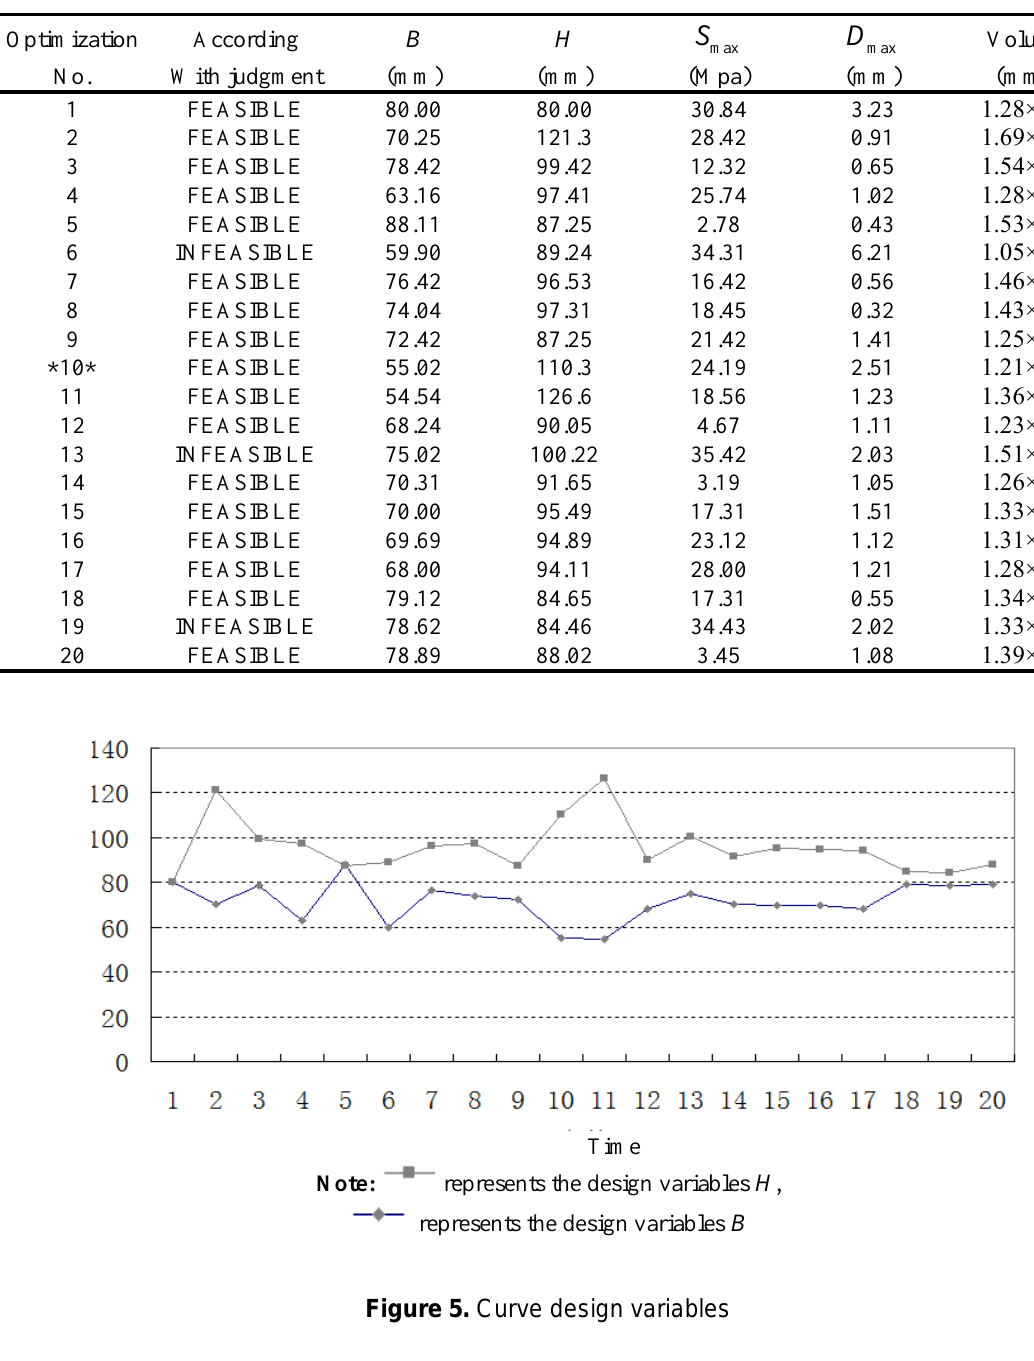
Table 2. Optimization results on the cross-section of larch wooden beams